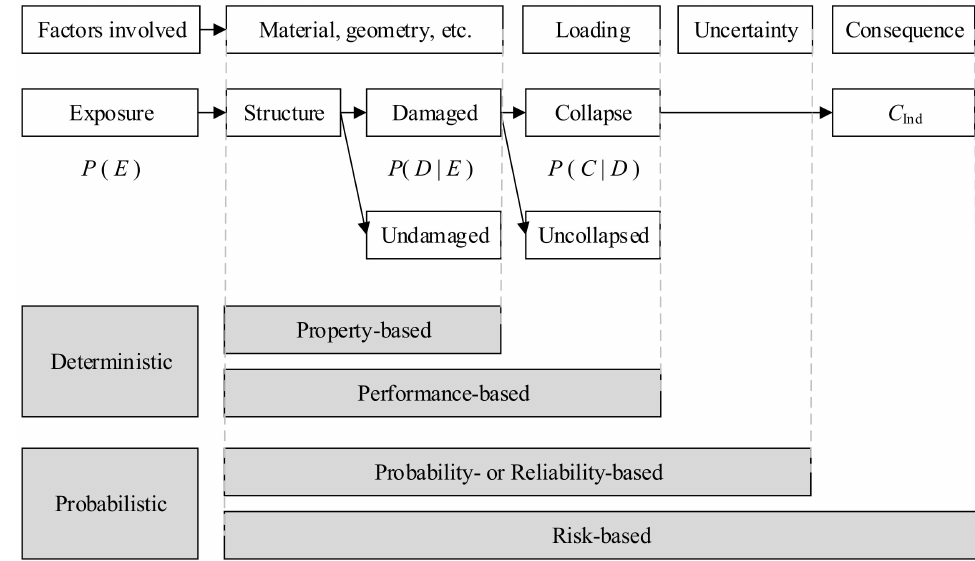
Figure 1. Classification of robustness